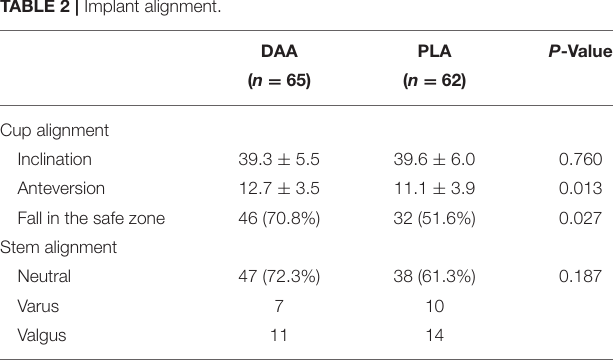
TABLE 2 | Implant